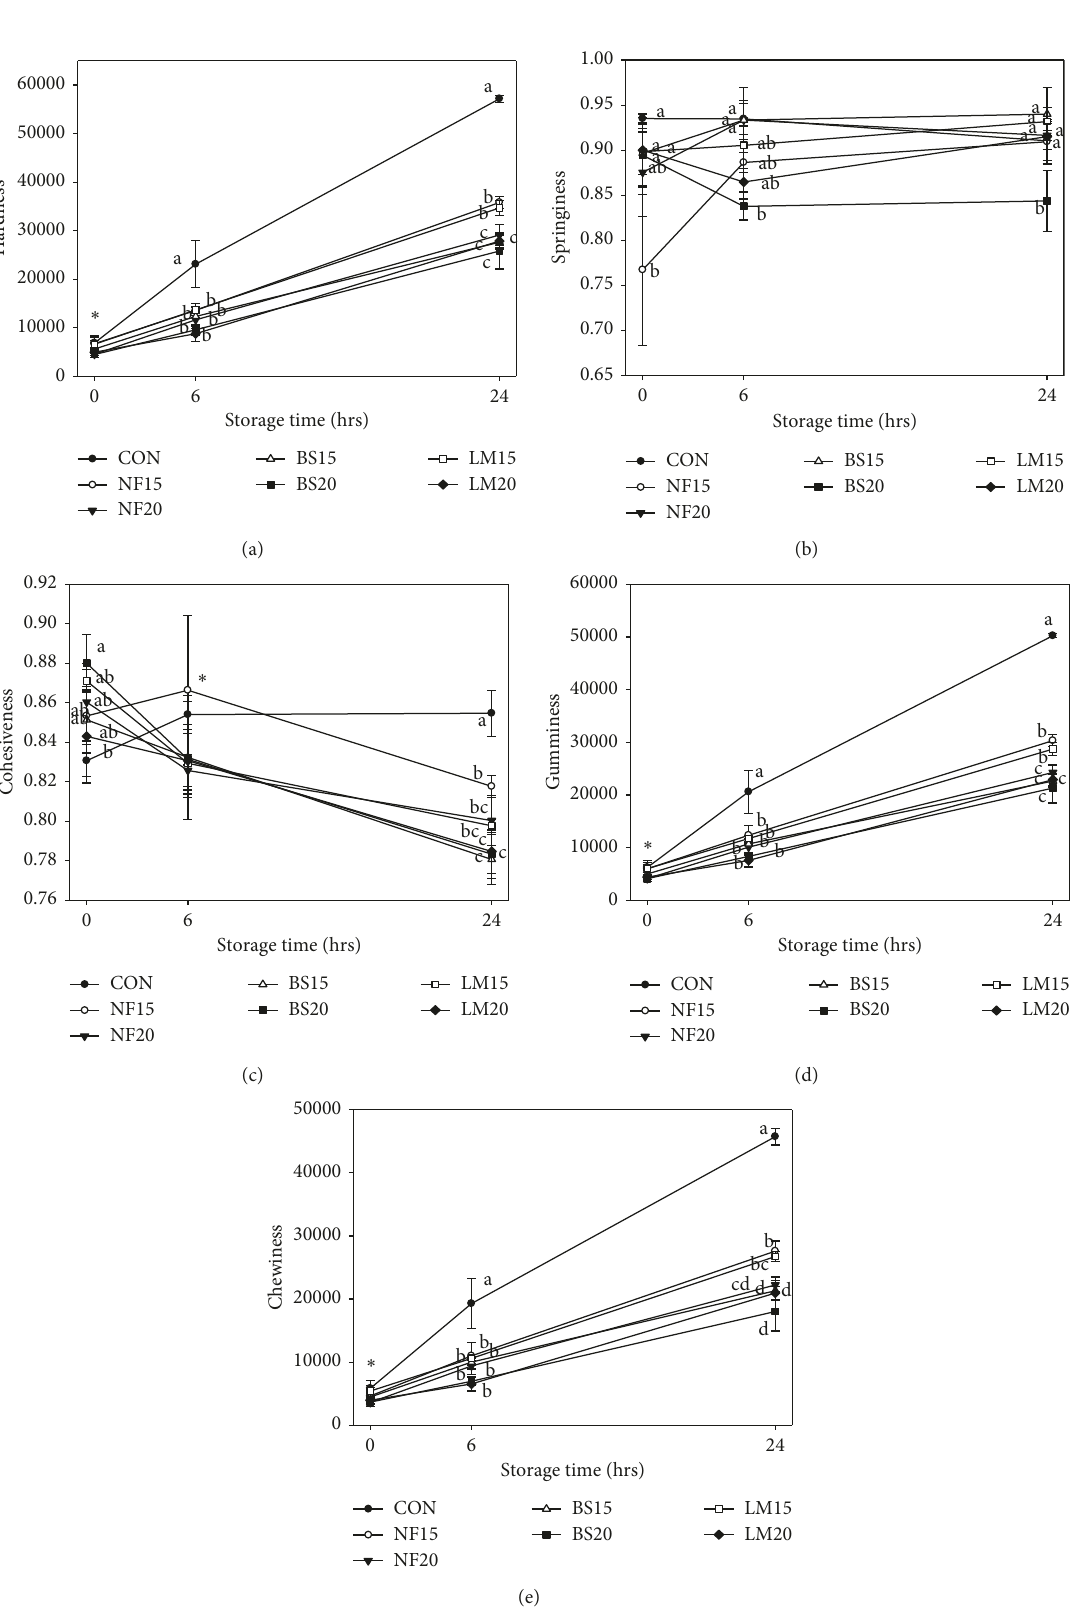
Figure 2: Change of texture profiles of cooked garaetteoks during storage 0, 6, and 24h: (a) hardness; (b) springiness; (c) cohesiveness; (d) gumminess; (e) chewiness. Means with different superscript letters measured at the same time are significantly different (one-way ANOVA, α � 0 . 05, Tukey’s post hoc